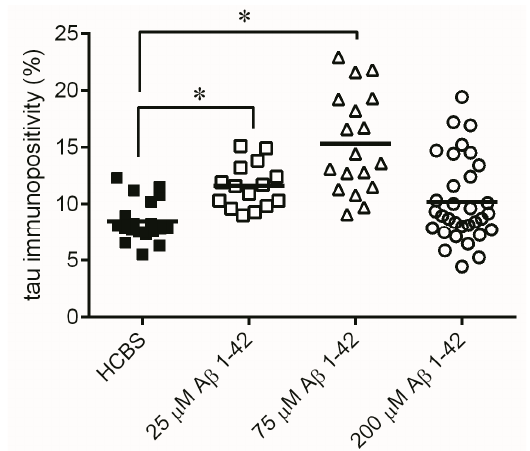
Figure 14. Tau-immunostaining of hippocampal slices after treatment of 168 h aggregated A β assemblies using increasing aggregation concentrations (25, 75 and 200 µ M) of synthetic A β 1-42. Each dot represents the counted raw data, while horizontal bars indicate mean values. Increasing number of tau immunopositive cells were observed comparing the HCBS and the 25 µ M oA β 1-42 treated ( p < 0.001), as well as the HCBS and the 75 µ M oA β 1-42 treated groups ( p < 0.001). There is no significant difference between HCBS and 200 µ M oA β 1-42 treated groups ( p = 0.284), n = 4, 4 slices/animal; n refers to the number of animals per group. Statistical significance was determined by one-way ANOVA, followed by a Games–Howell post hoc test. * Differences with a p -value < 0.05 were considered significant. Representative examples of coronal HC sections show neurons after 25, 75 and 200 µ M oA β 1-42 administration with 24 h aggregation time (Figure 15A–D) using cresyl violet staining. The abnormal aggregated NFTs are demonstrated in Figure